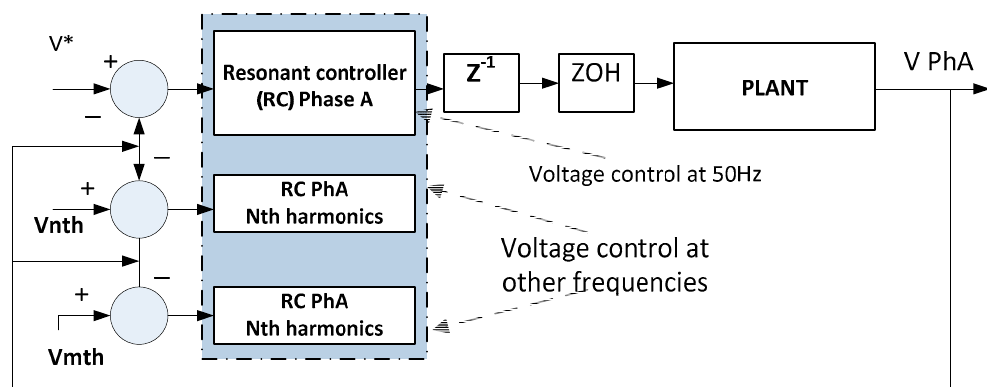
Figure 14. The Resonant Controller (RC) for voltage control at 50 Hz and different harmonics elimination.